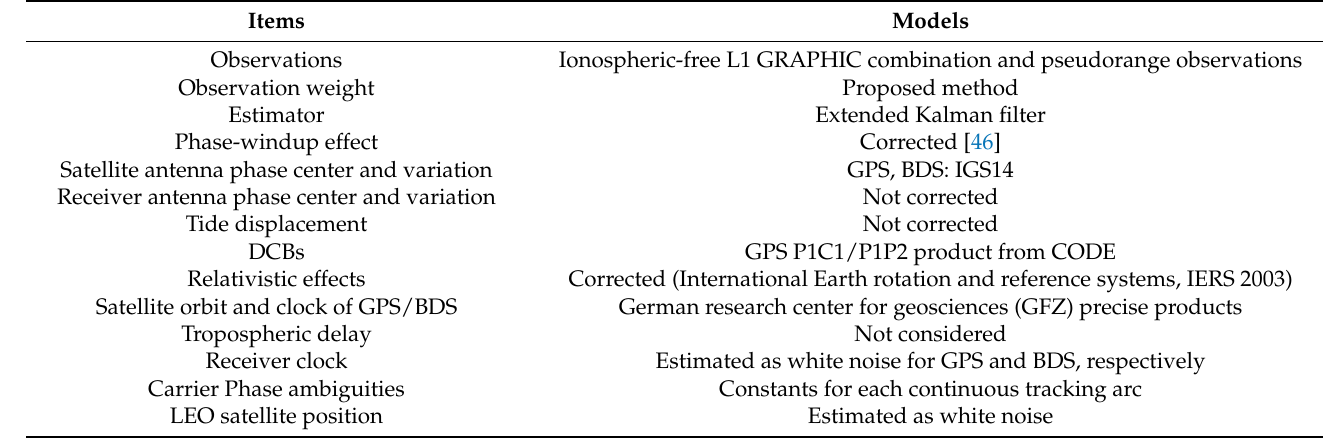
Table 1. Processing configuration of the Luojia-1A kinematic orbit determination method with single-frequency data.